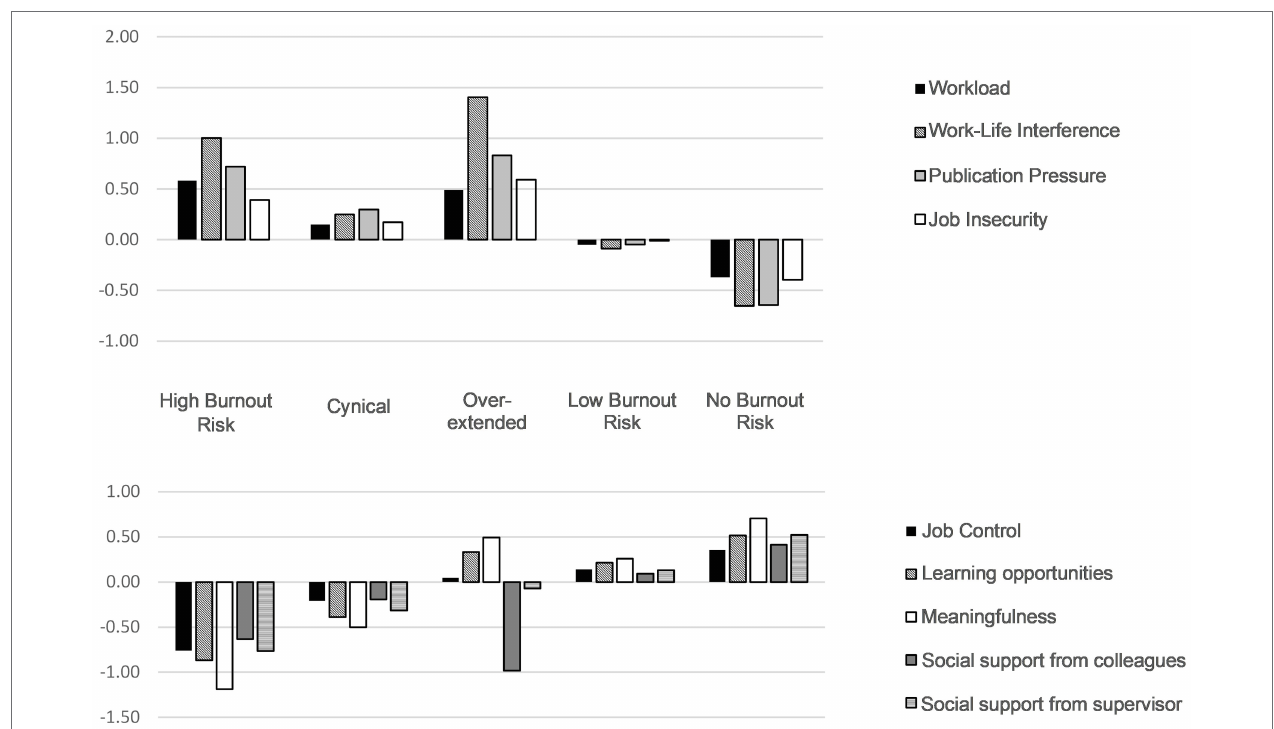
FIGURE 3 | Standardized means of the predictors by latent burnout